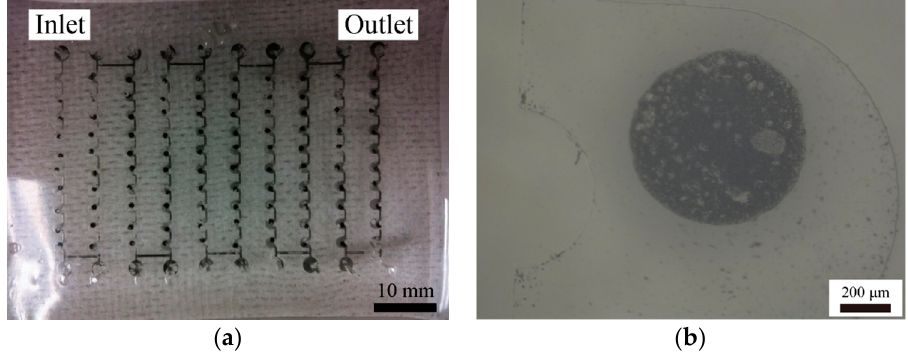
Figure 10. Observation of the fabricated microvalve array device in ( a ) whole view of the device and ( b ) enlarged view of microvalve element.